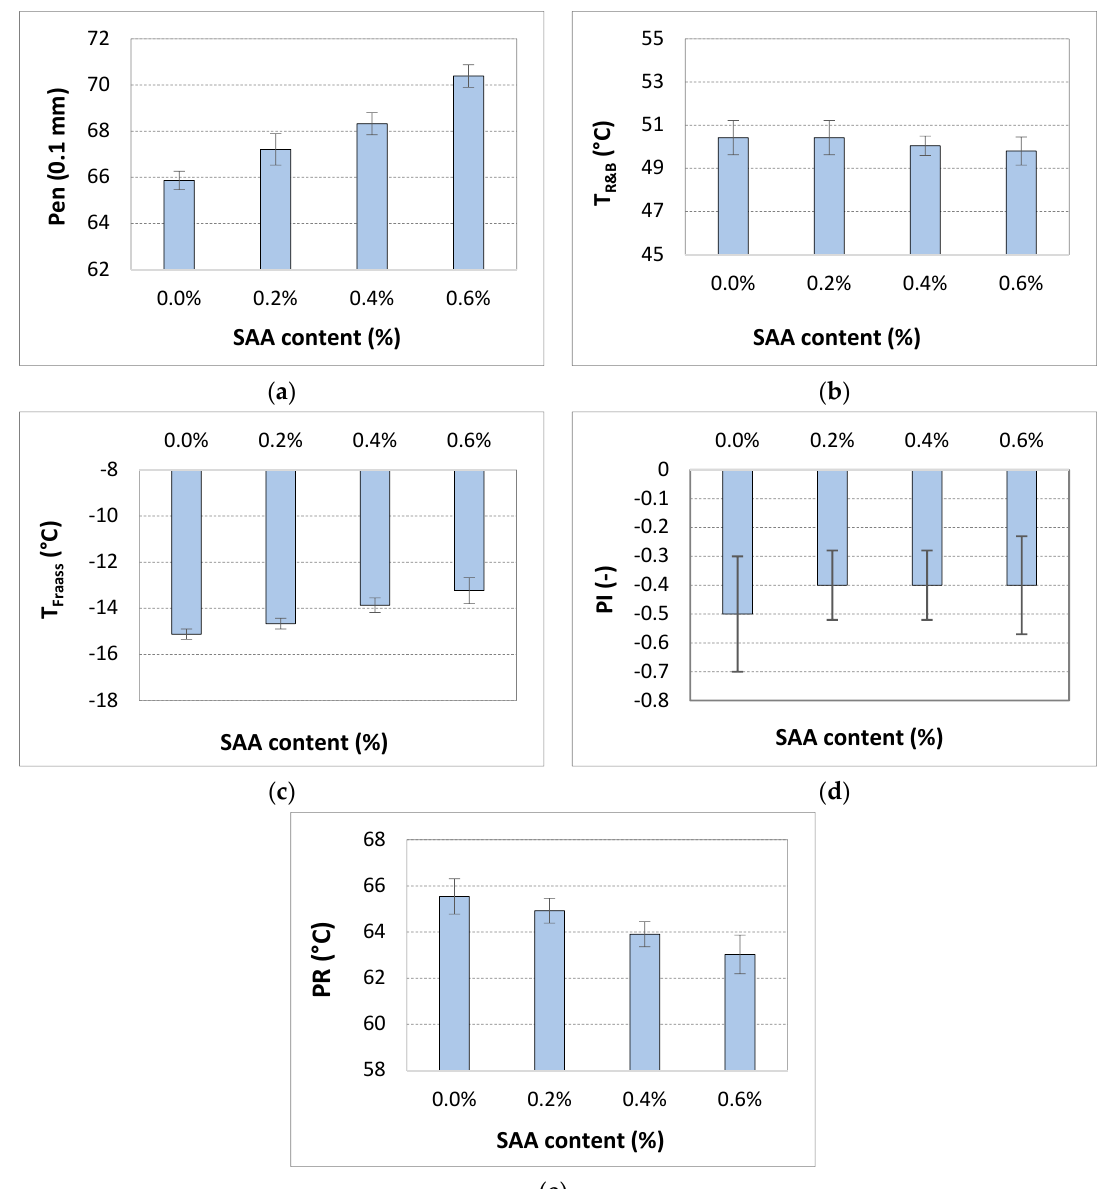
Figure 1. E ff ect of SAA content on the properties of 50 / 70 bitumen, a ) penetration, b ) softening point, c ) Fraass breaking point, d ) penetration index, e ) plasticity range (error bars represent standard